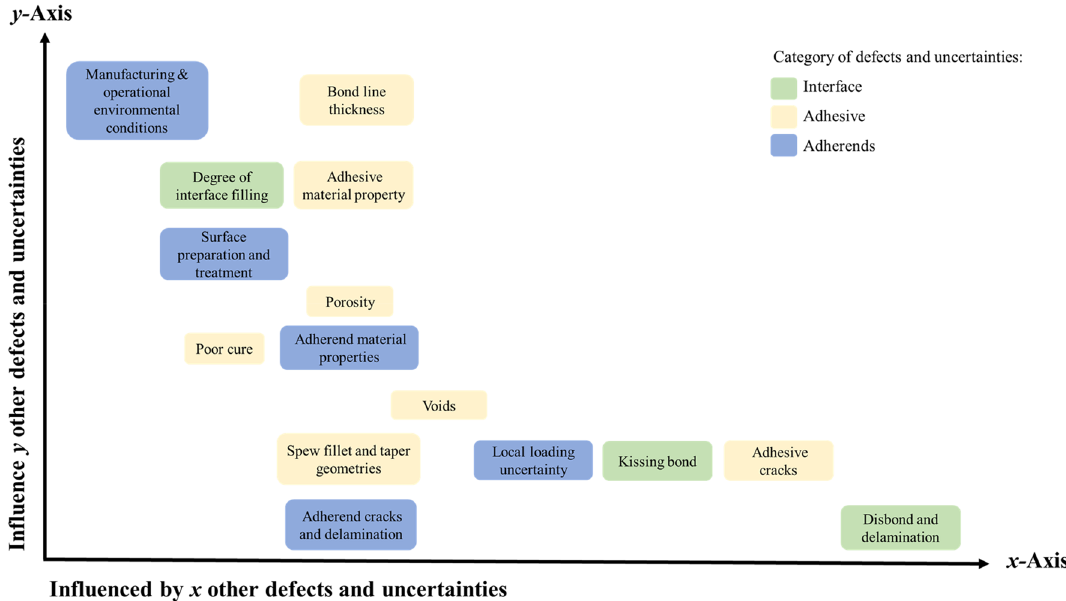
Fig. 12 Indicative influence level of the investigated defects and